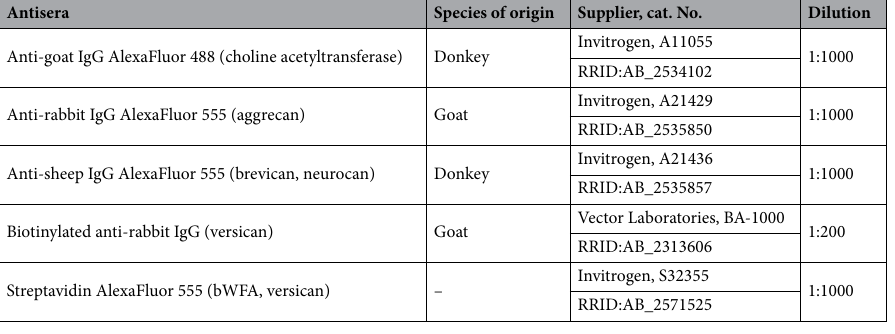
Table 2. Fluorescent secondary